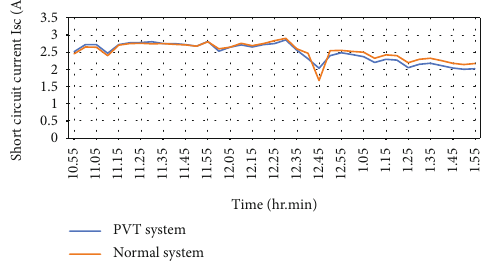
Figure 7: Short circuit current (Isc) of the PVT and the normal system. Average reduction in Isc of PVT system is 0.04A compared to the normal system and maximum reduction in Isc is 0.16